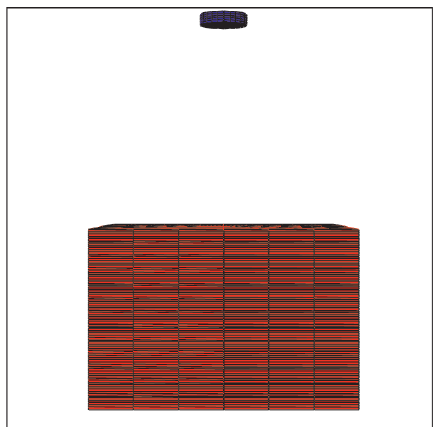
Figure 12: Geometrical model.